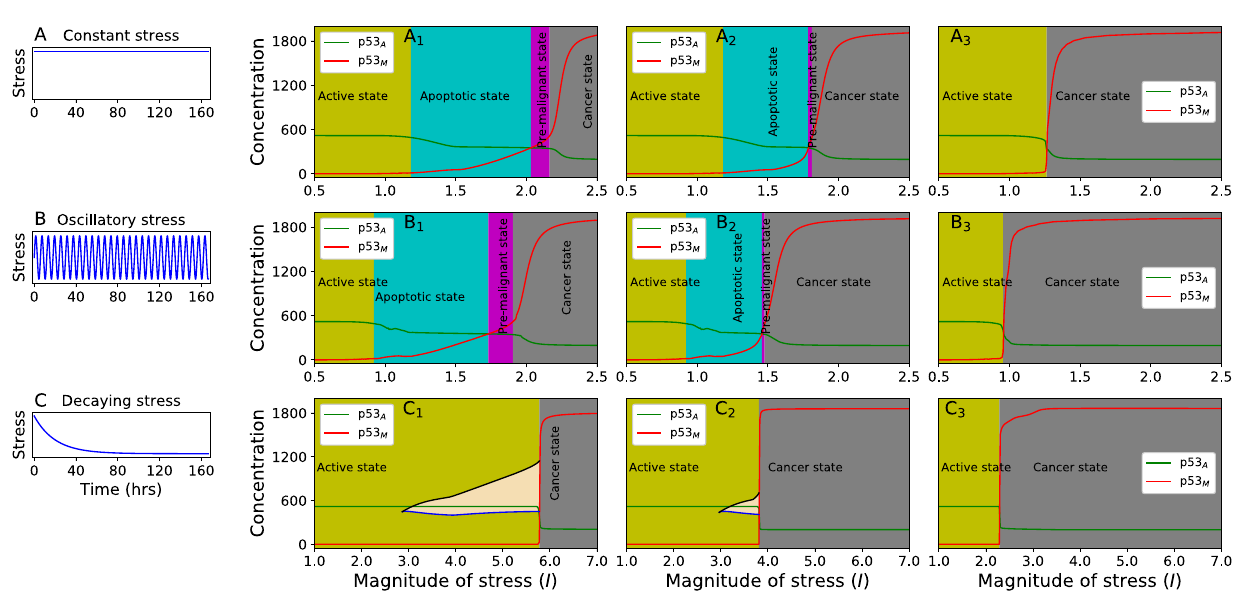
Figure 4. The left column show three different form of stress discussed about. A 1 , A 2 , and A 3 display the steady state behaviour against magnitude of stress for different K 3 values 1000.0, 500.0, and 100.0 respectively driven with constant stress. B 1 , B 2 , and B 3 display the steady state behaviour against magnitude of stress for different K 3 values 1000.0, 500.0, and 100.0 respectively driven with oscillatory stress. C 1 , C 2 , and C 3 display the steady state behaviour against amplitude for different K 3 values 1000.0, 500.0, and 100.0 respectively driven with decaying stress. Yellow region, cyan region, and grey region correspond to active, apoptotic, premalignant, and cancer state respectively. In panel C 1 , and C 2 (wheat region) black line (upper line), and blue line (lower line) show maximum of p53 M , and maximum of p53 A in T ps (see the text) time region, which corresponds to the initial cancer